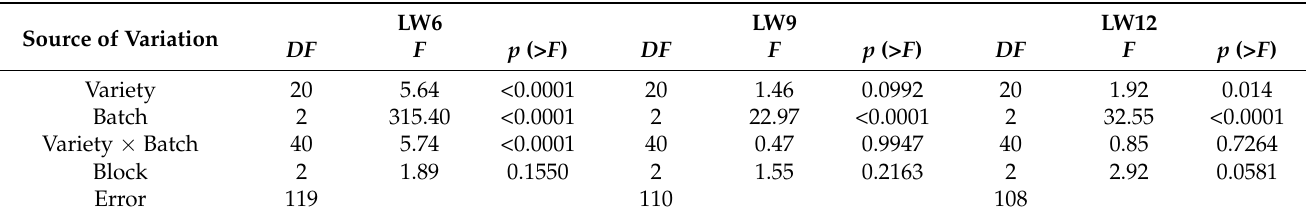
Table 2. The joint ANOVA of larval weight of common cutworm feeding on four sensitive and seventeen resistant yardlong bean varieties in three verification experiments.